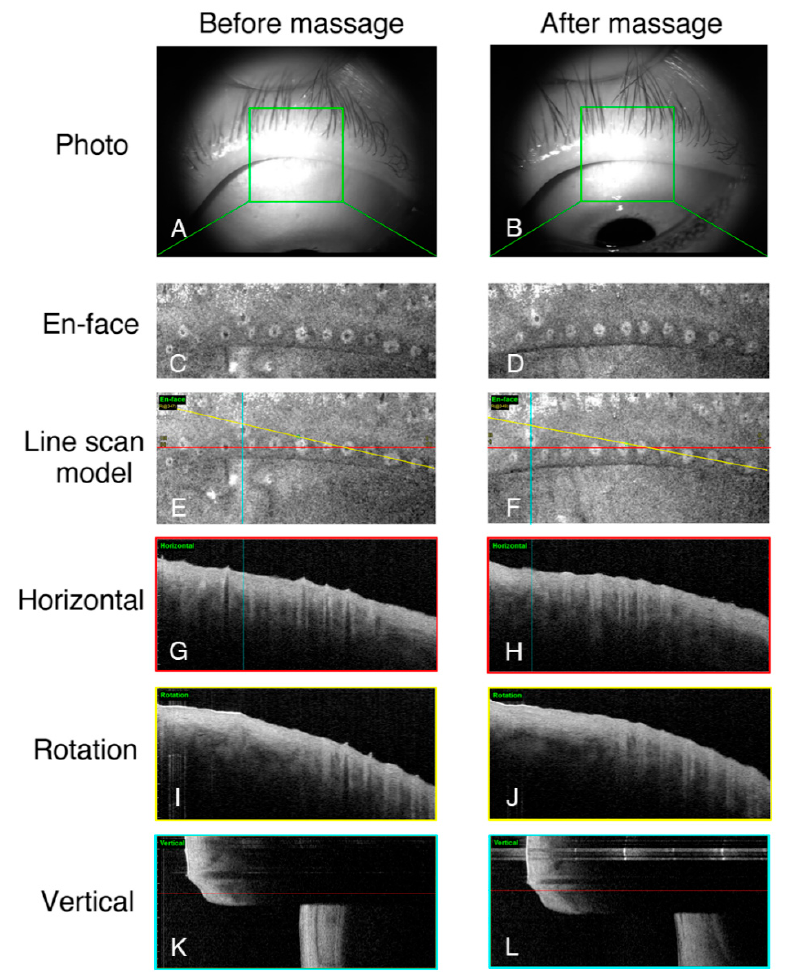
Figure 5. The changes in the meibomian gland openings before ( left ) and 30 min after ( right ) meibomian massage. In this study, we chose the same area for examination to the best of our abilities ( A , B ). The changes in the characteristics of the orifices are clearly shown in the en-face images ( C , D ). With the help of a line scan ( E , F ), the same terminal gland ducts in two examinations can be compared horizontally ( G , H ), rotationally ( I , J ), or vertically ( K , L ).